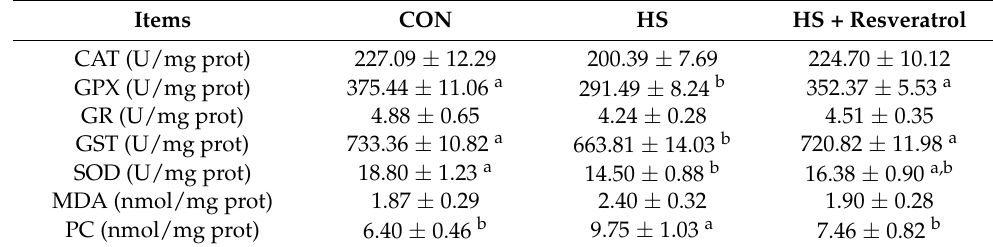
Table 6. Effect of resveratrol on antioxidant status in jejunum of broilers under